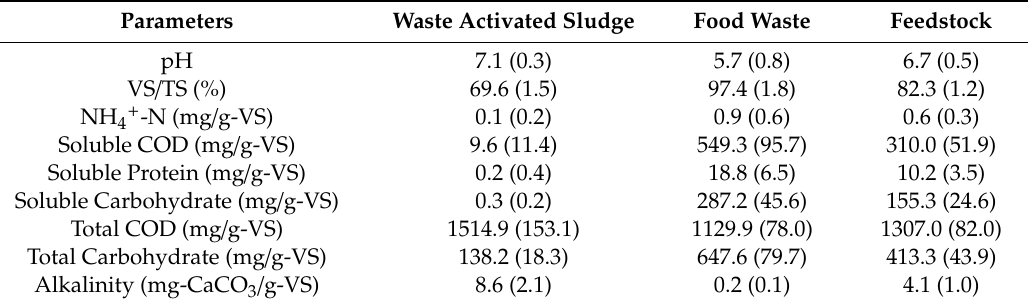
Table 1. Characteristics of the substrates and feedstock.